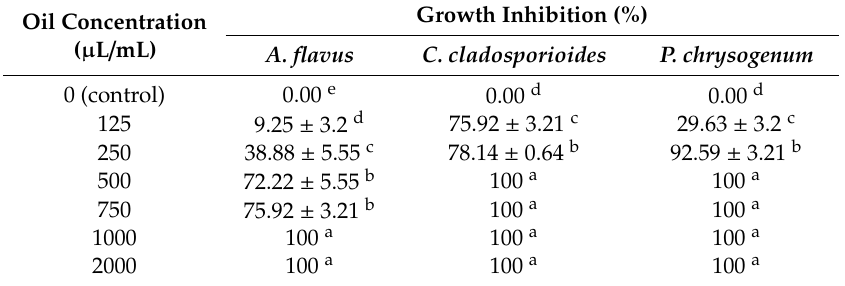
Means with the same letter within the same column are significantly di ff erence according to the Least Significant